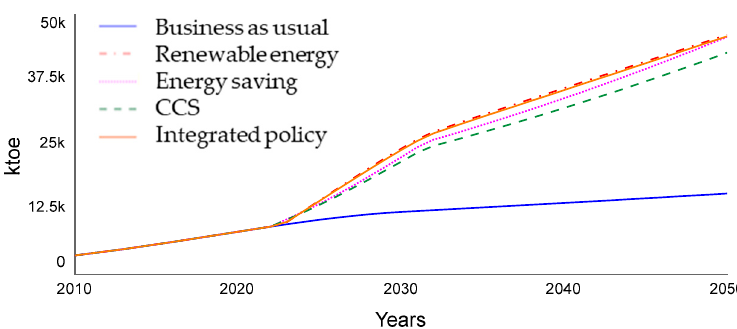
Figure 8. Total renewable energy per year 2010 – 2050.